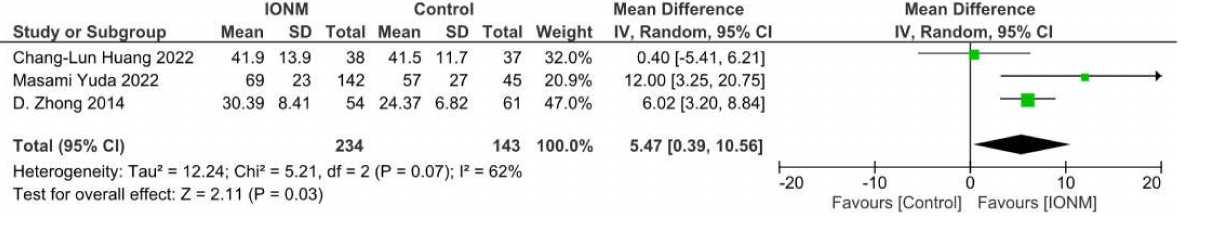
Figure 8. Forest plot of IONM for total LN dissected. Abbreviations: IONM— intraoperative